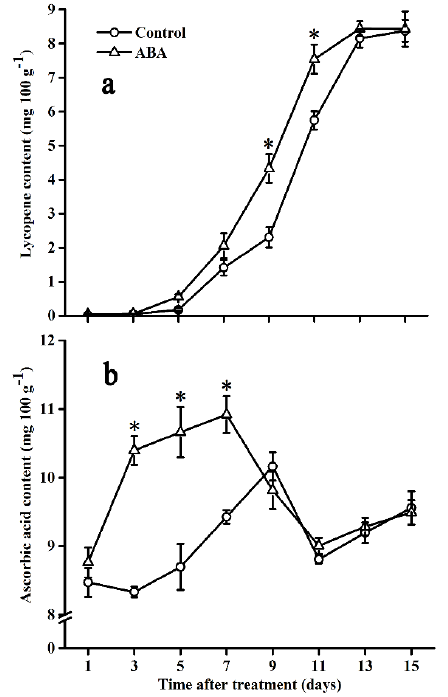
Figure 4. E ff ect of ABA on lycopene ( a ) and ascorbic acid ( b ) contents in the tomato during storage at 20 ◦ C. Vertical bars represent the standard deviation (SD, n = 3). Asterisks (*) represent significant di ff erences ( p < 0.05) between the ABA and control